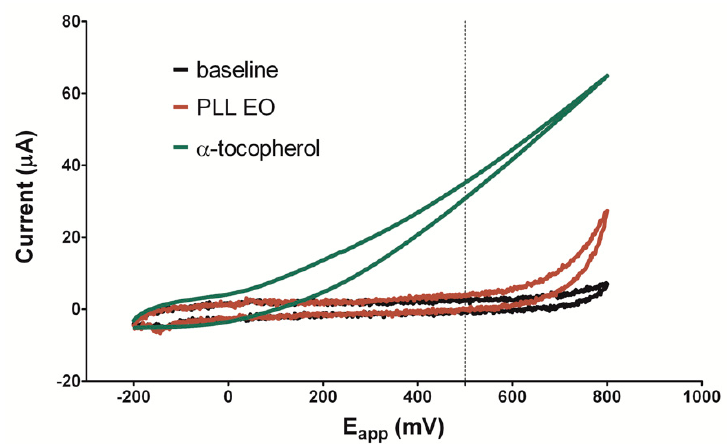
Figure 3. Cyclic voltammetry of PLL-EO with a scanned potential range (E app ) between -200 mV and +800 mV vs Ag/AgCl reference electrode, in the absence (black line) and in the presence of 200 mg/mL PLL-EO (red line), in comparison with 1 mM α -tocopherol (green line).